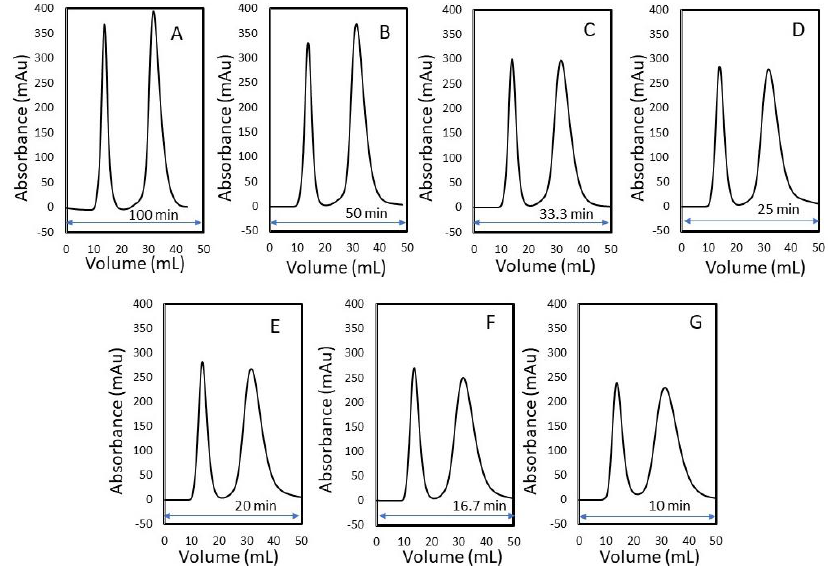
Figure 6. Comparison of chromatograms obtained during BSA (5 mg/mL) and lysozyme (2.5 mg/mL) separation using the 24 mL z 2 cuboid SEC device at different flow rates (medium: Sephacryl S-200 HR; mobile phase: phosphate-buffered saline (pH 7.4); loop size: 2 mL): ( A ) 0.5 mL/min, ( B ) 1.0 mL/min, ( C ) 1.5 mL/min, ( D ) 2 mL/min; ( E ) 2.5 mL/min; ( F ) 3 mL/min; ( G ) 5